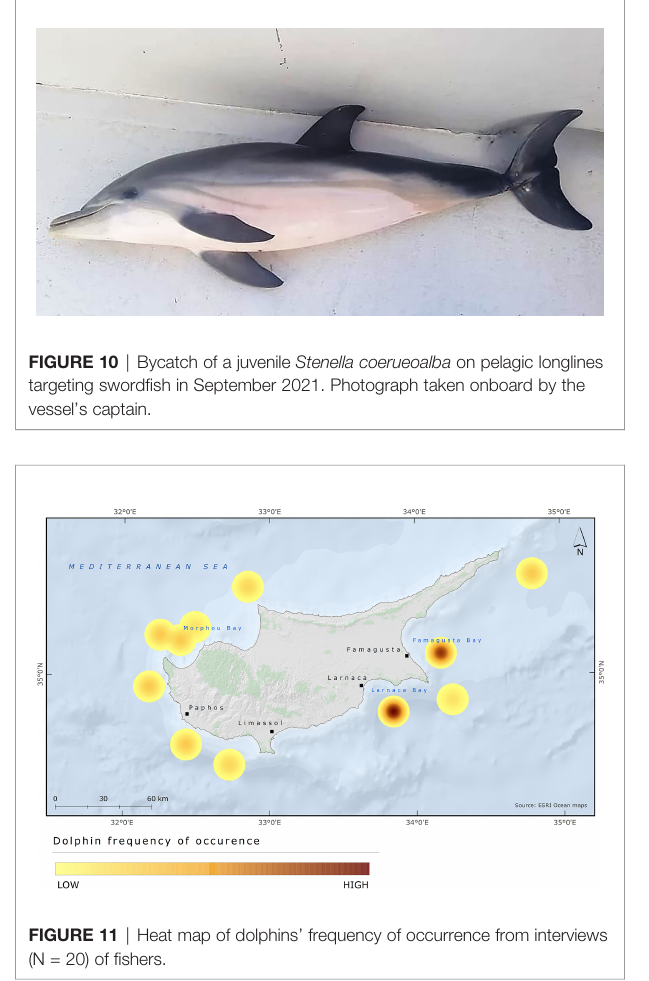
FIGURE 11 | Heat map of dolphins ’ frequency of occurrence from interviews (N = 20) of fi